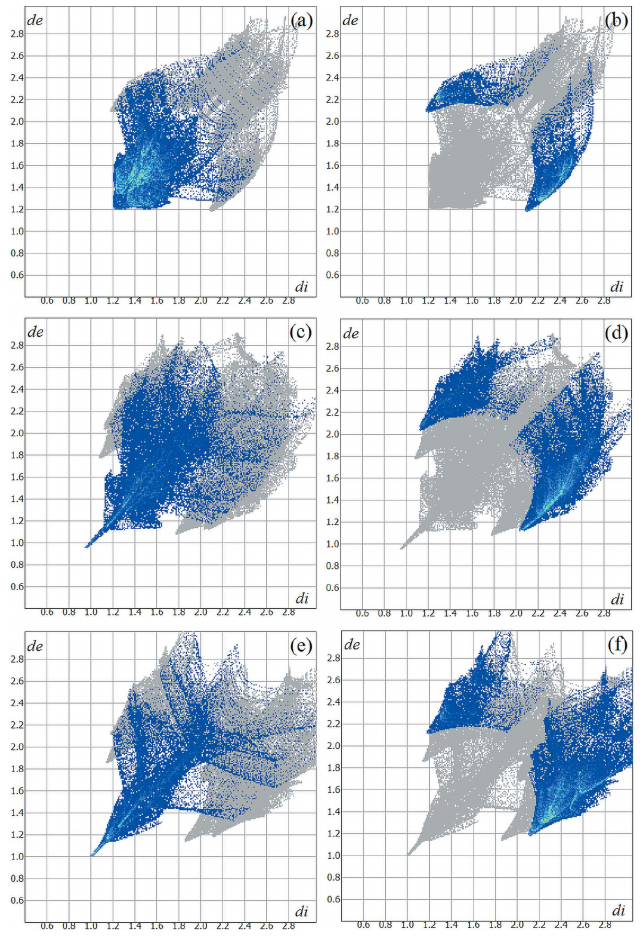
Figure 7 Two-dimensional Hirshfeld surface fingerprint plots for the (cid:4) , (cid:5) and (cid:6) (OMTTF (cid:4) + )(I 3 (cid:3) ) crystalline modifications. The H (cid:2)(cid:2)(cid:2) H and H (cid:2)(cid:2)(cid:2) I inter- molecular contacts are drawn as cyan dots. The contributions of these interactions for the crystal packing of the (cid:4) form amount to ( a ) 43.30% and ( b ) 17.40%, respectively. For the (cid:5) form the values amount to ( c ) 29.20% and ( d ) 33.90% and, finally, for the (cid:6) form the values are ( e ) 23.00% and ( f )